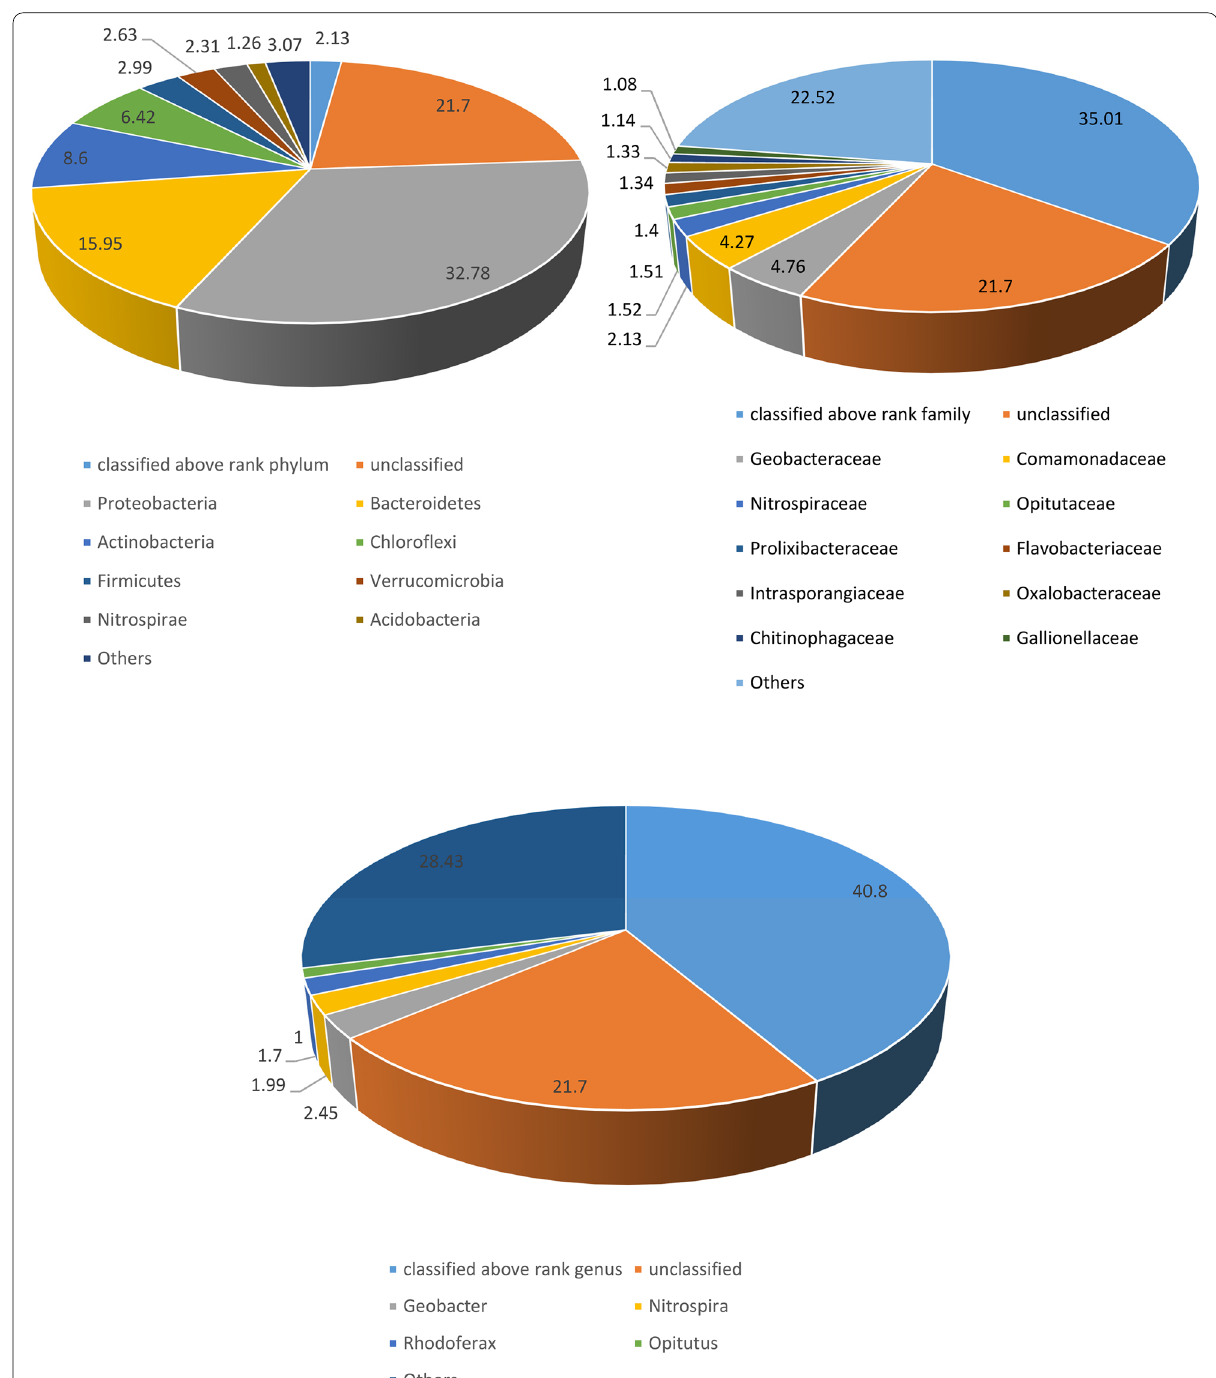
Fig. 1 The figure depicts the abundance of bacterial communities of ABS1 sample at different taxonomic units (Phylum Family and Genus). Lesser than 1% of the distribution were together labeled as